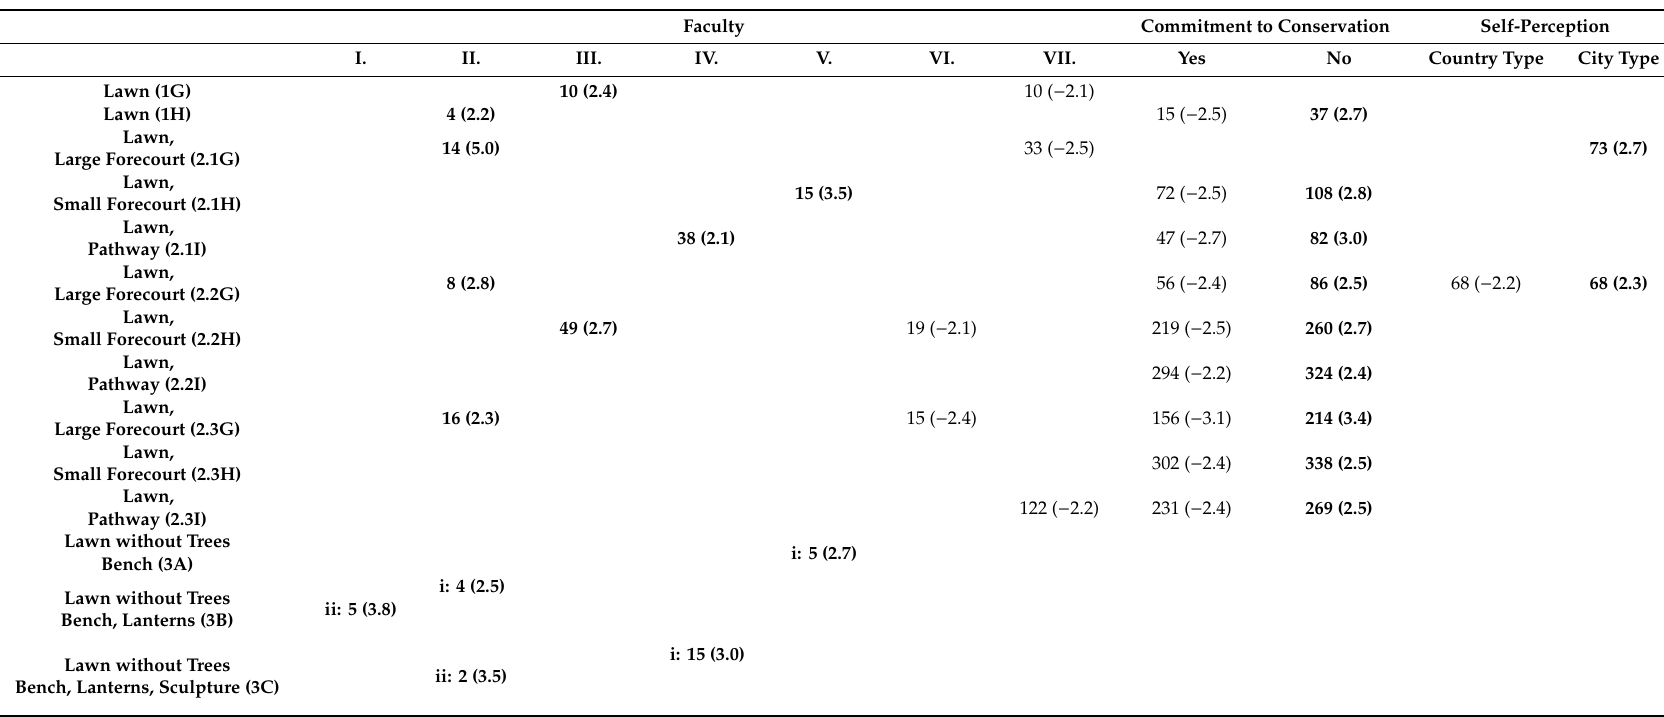
Table A3. Table of the all presented lawn areas that were significant with respect to faculties, commitment to nature conservation, and peoples’ self-perception. The table presents the number of choices for a certain green space by the respective sociodemographic group (standardized residuals in brackets). Whereas a positive residual indicates that the scenario was appreciated by the relevant demographic group (bold type), a negative residual indicates that the scenario was disliked (normal typeface). Question 3 was divided into four sub-questions; each picture was presented twice as two separate questions: the results of (i) the first sub-question are shown in the upper line; results of (ii) the second sub-question in the lower